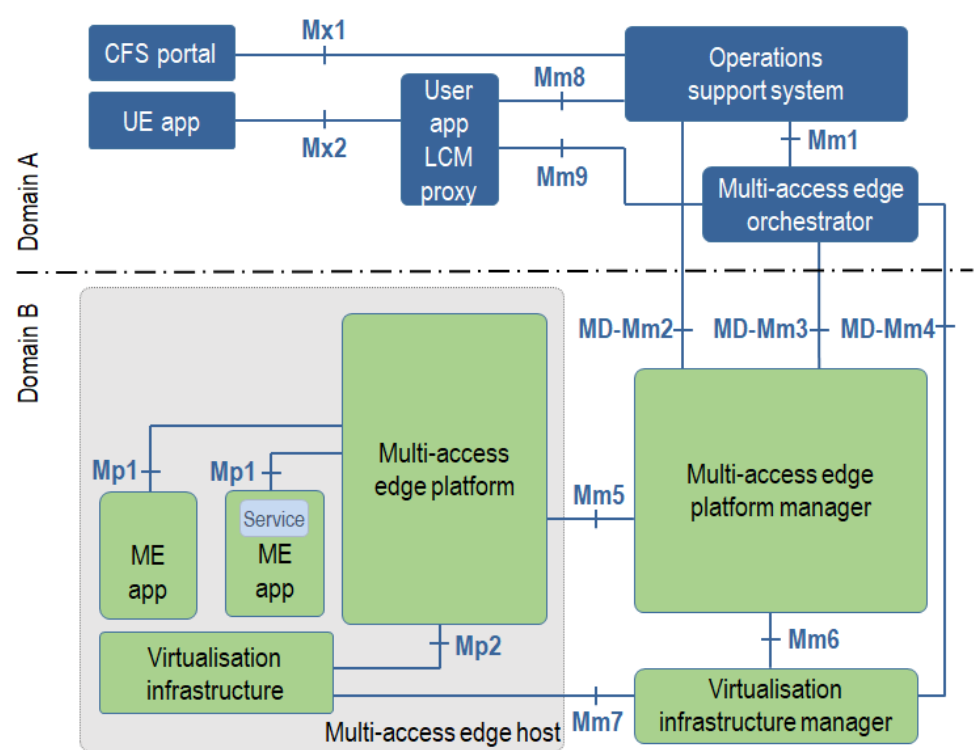
Figure 5. Integration of MEC providers at service level.